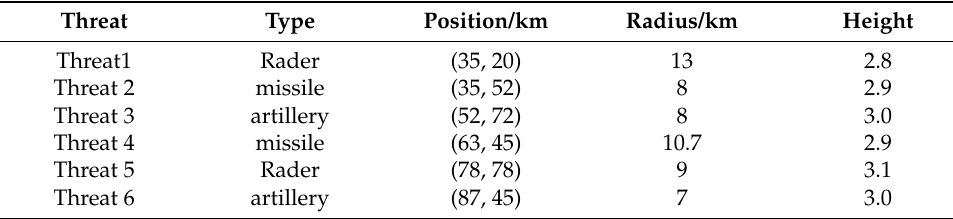
Table 3. Threat source settings.